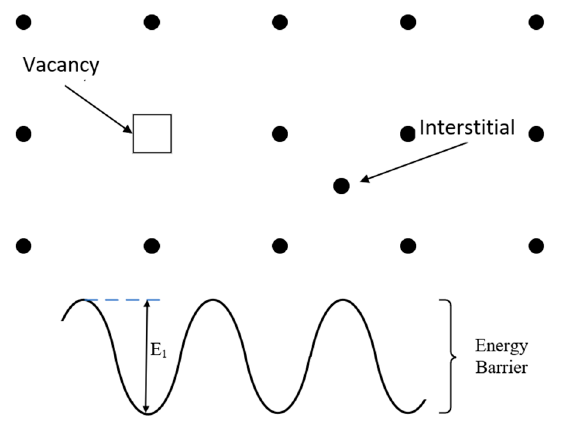
Figure 9. Schematic diagram of the positions of vacancies and defects in the crystal and the potential barriers around the vacancies. barriers around the